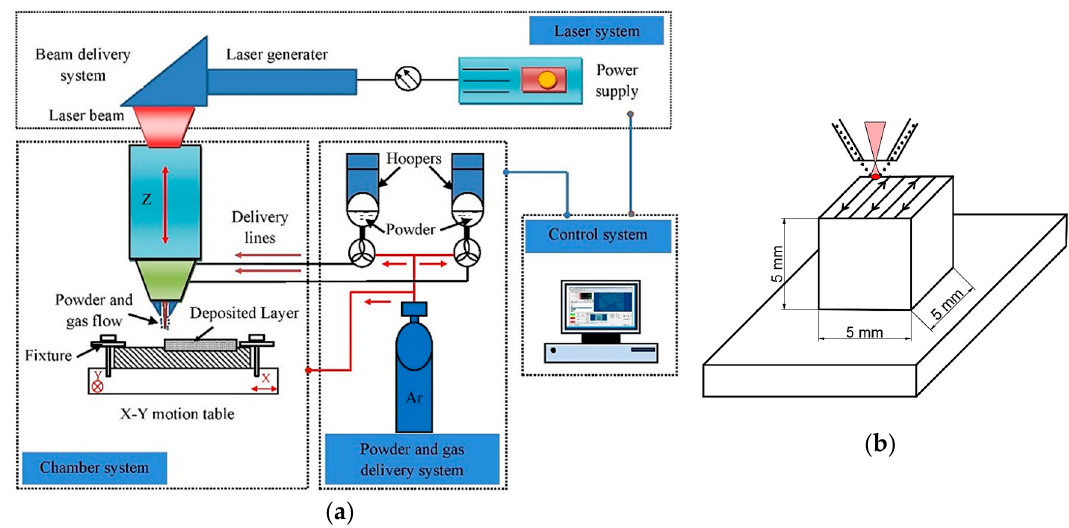
Figure 2. ( a ) LENS 450 system schematic diagram; ( b ) Scanning pattern in the laser engineered net shaping (LENS) process.